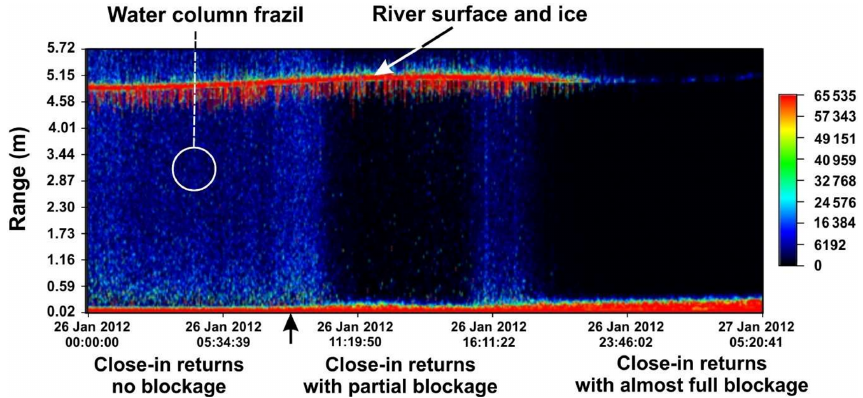
Figure 4. Echogram of the channel 4 (774kHz) returns during the first blockage event. The vertical arrow below the time axis denotes the approximately 08:00MST start of the thickening of the close-in returns discussed in the text as indicative of transceiver blockage onset.